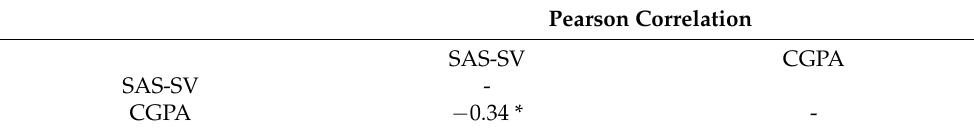
Table 10. Pearson correlation between smartphone addiction and academic performance.